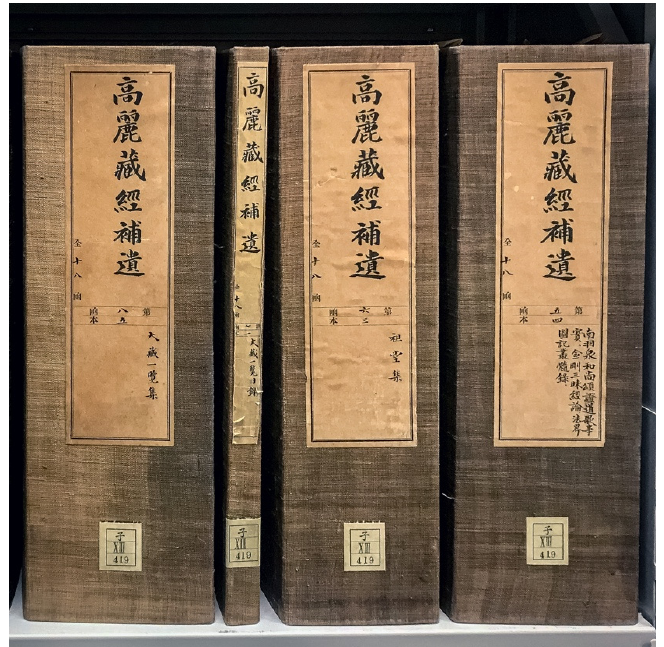
Figure 3. The case in the center of the image contains the prints of the ZTJ as stored at the Library of the Institute for Research in Humanities of Ky ō to University (photograph by Christian Wittern, Ky ō to University).